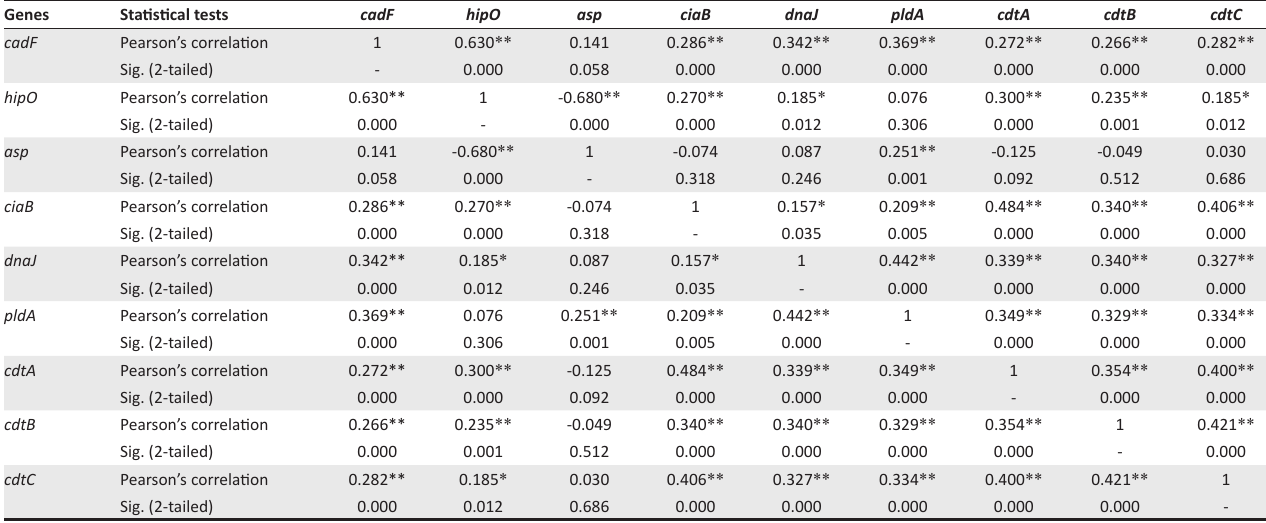
TABLE 2: Comparison of Pearson’s correlations for virulence genes detected in Campylobacter species from human clinical isolates and chicken faeces. Genes Statistical tests Pearson’s correlation